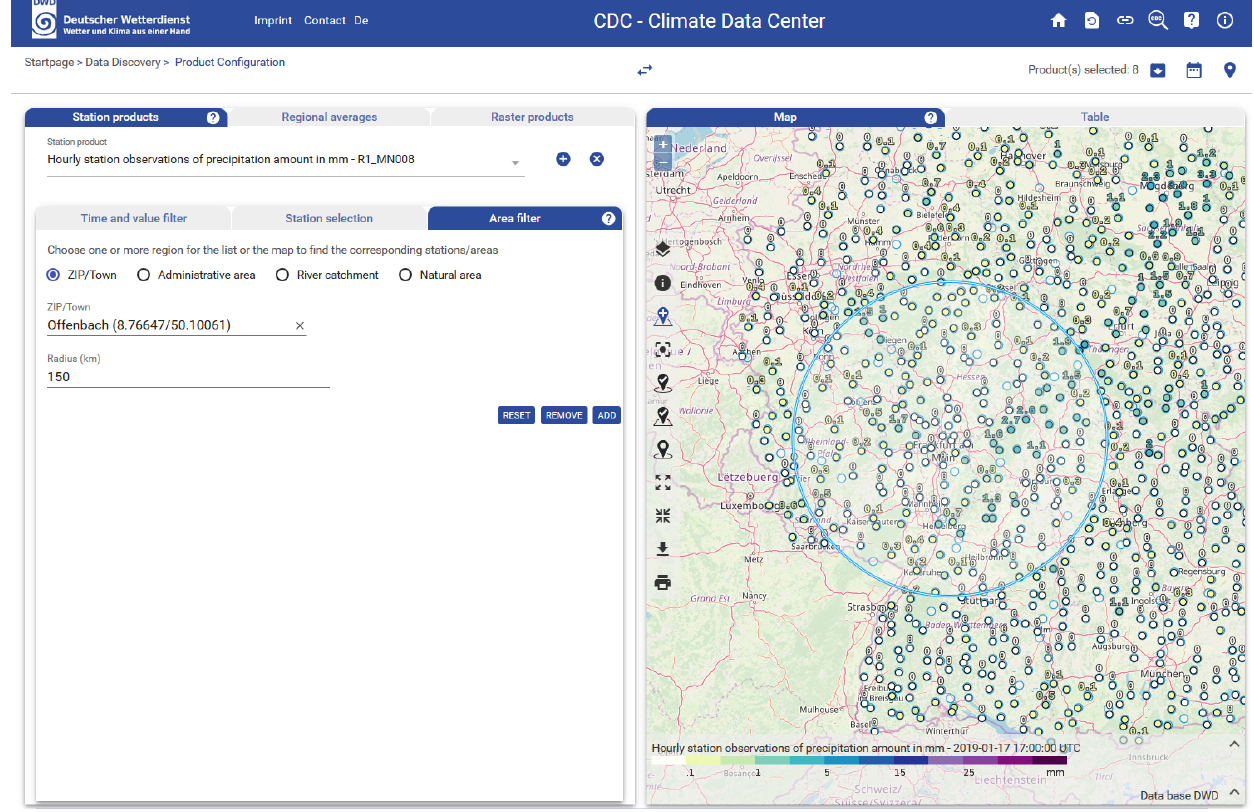
Figure 7. Example of the application of a geographic filter (Source: Deutscher